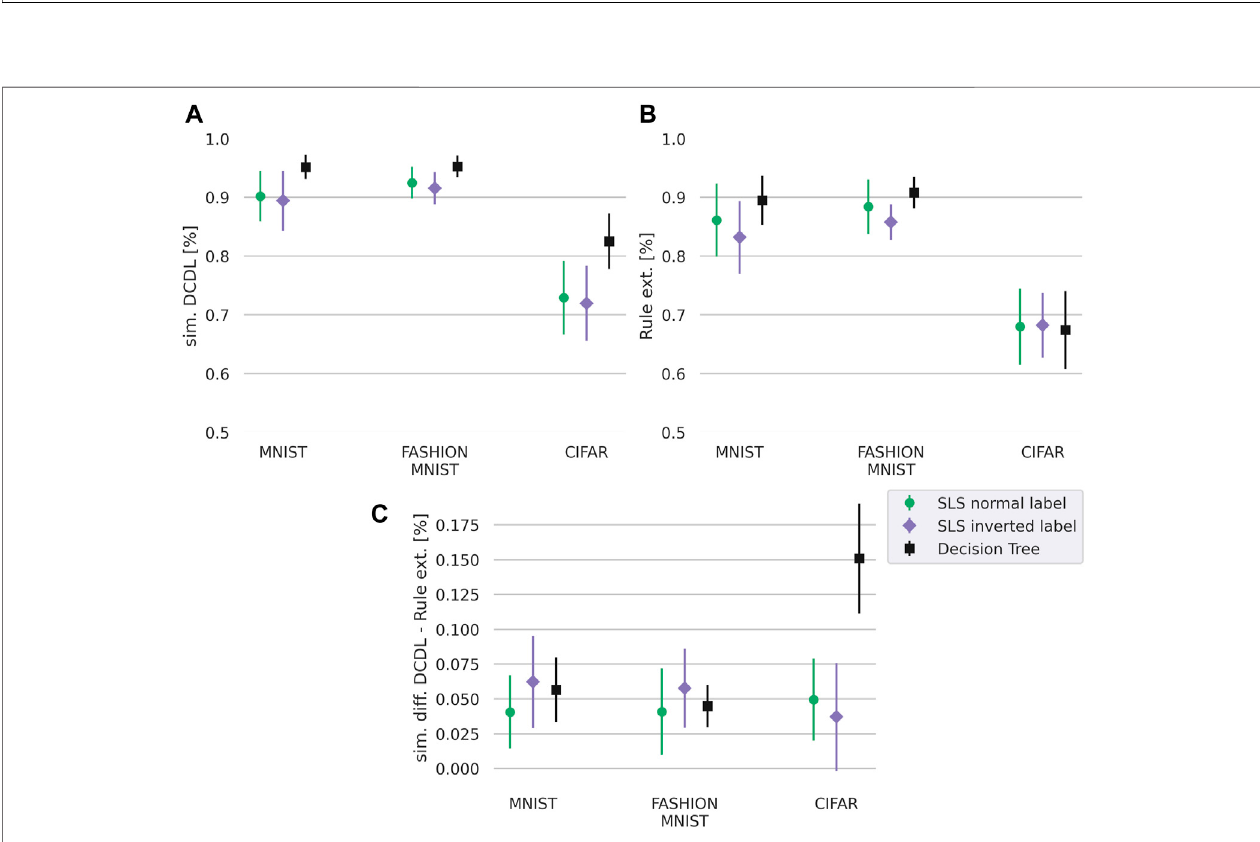
FIGURE 4 | Similarity of the DCDL (A) and rule learning approaches (B) where for SLS we set k (cid:2) 40. Difference in similarity between both approaches (C) . The similarityiscalculatedwithrespecttothepredictionoftheneuralnetworkonthetestset.TheDCDLapproachhashighersimilarityacrossallthreedatasets.Thestandard deviation is calculated from 30 runs overall, 3 for each class. The numeric values are given in Table 9 in the Supplementary Appendix .